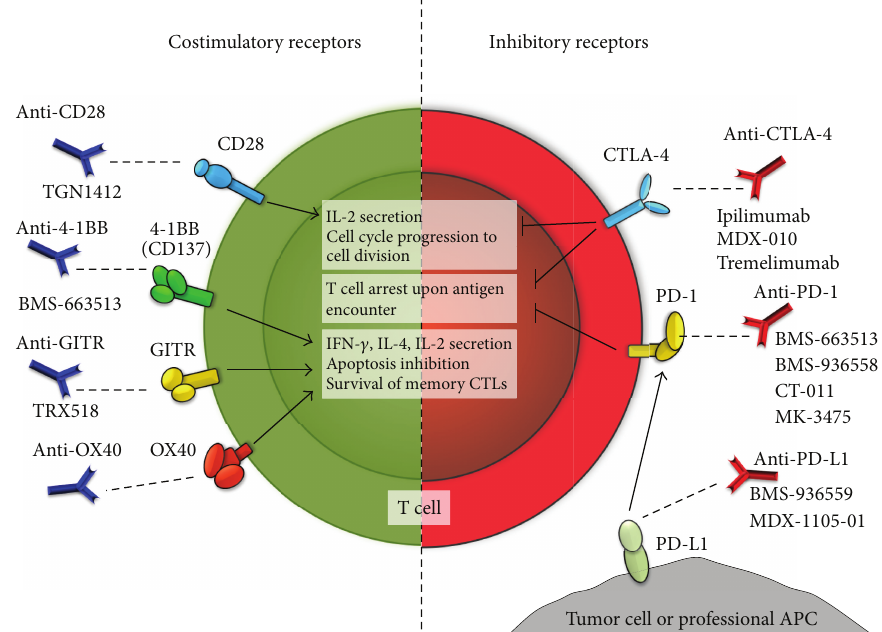
Figure 4: Novel therapeutic approaches targeting the immunological synapse to enhance antitumor immunity. Left. Costimulatory molecules either constitutively expressed (e.g., CD28) or inducible (e.g., 4-1BB, GITR, and OX40) that have or are being considered as targets for antitumor immunotherapy due to their positive effects on T cells after engagement (central white boxes). Right. Inhibitory molecules that have been shown to play roles in the suppression of antitumor T cells and that are expressed either at the surface of T cells (e.g., CTLA-4, PD-1) or at the surface tumor cells and professional APCs (e.g., PD-L1). Blunt arrows indicate the physiological processes (white boxes) that are affected upon the engagement of these molecules. The names of different monoclonal antibodies in present or past clinical evaluation are indicated below each